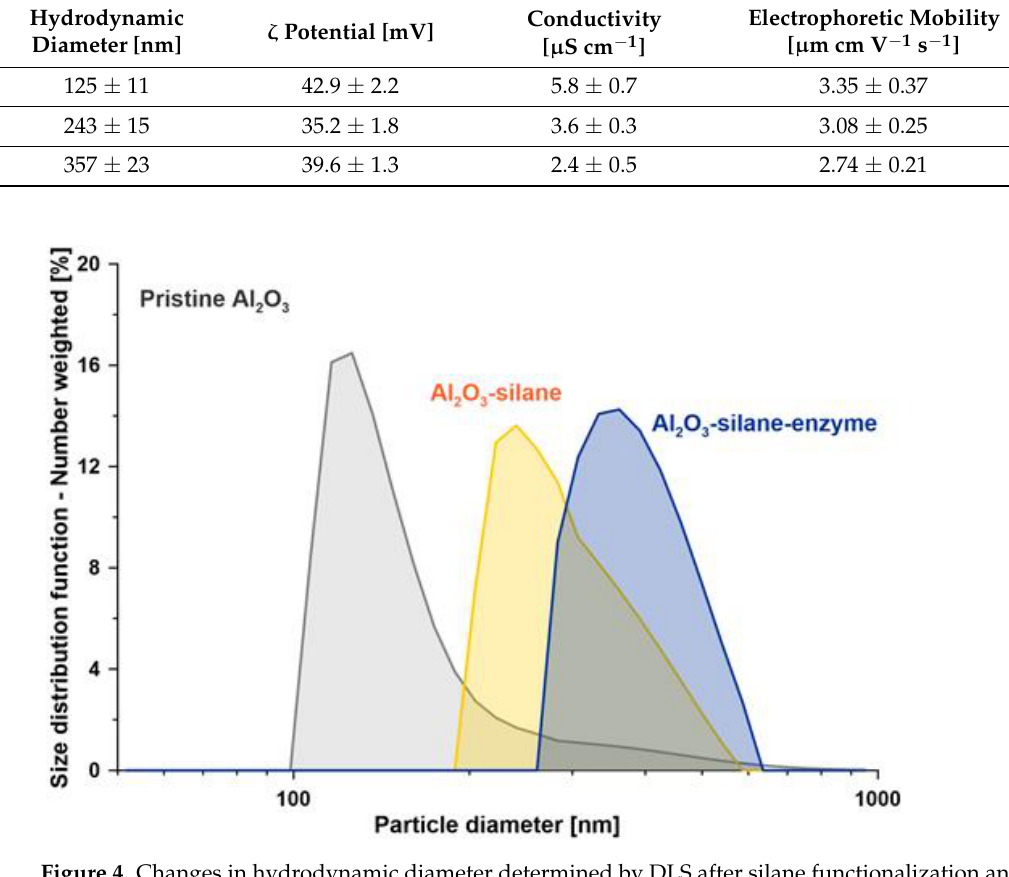
Figure 4. Changes in hydrodynamic diameter determined by DLS after silane functionalization and enzyme immobilization. Table 1. DLS and ζ (zeta potential) characteristics of the ceramic materials.